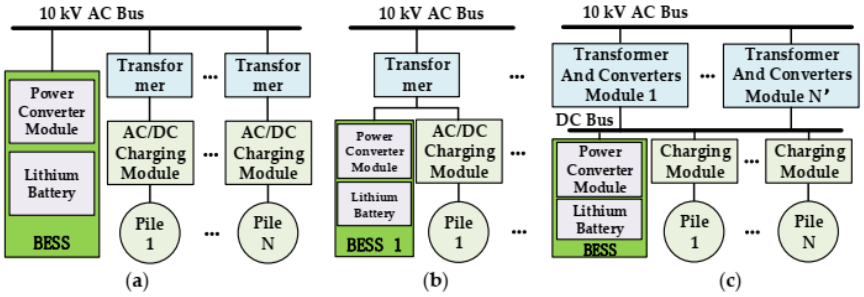
Figure 10. Three strategies of BESS configuration: ( a ) scenario 1—integrate the BESS with the AC bus; ( b ) scenario 2—integrate the BESS with each charging pile; ( c ) scenario 3—integrate the BESS with the DC bus. (Reprinted from Ref. [108].)